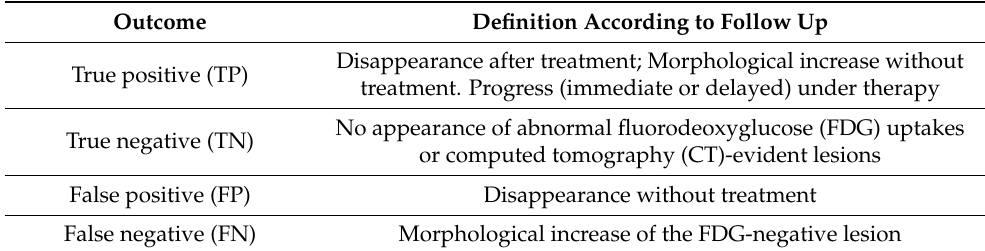
Table 1. Table 1. Criteria of lesion classification.